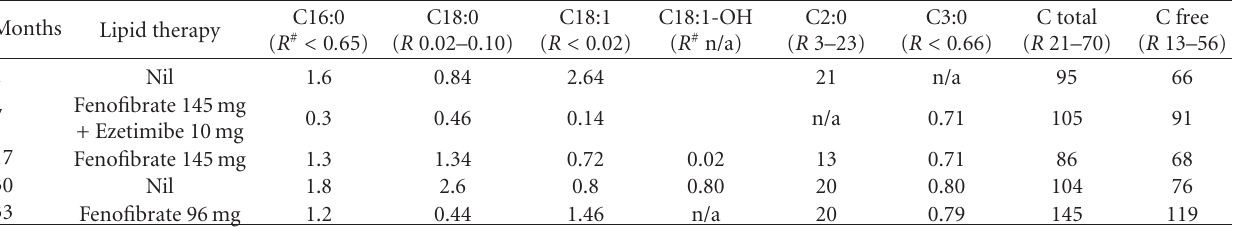
∗ TC: total cholesterol, TG: triglycerides, HDL-C: high density lipoprotein cholesterol, LDL-C: low density lipoprotein cholesterol (mmol/L). Table 2: Changes in acylcarnitine levels (umol/L) with